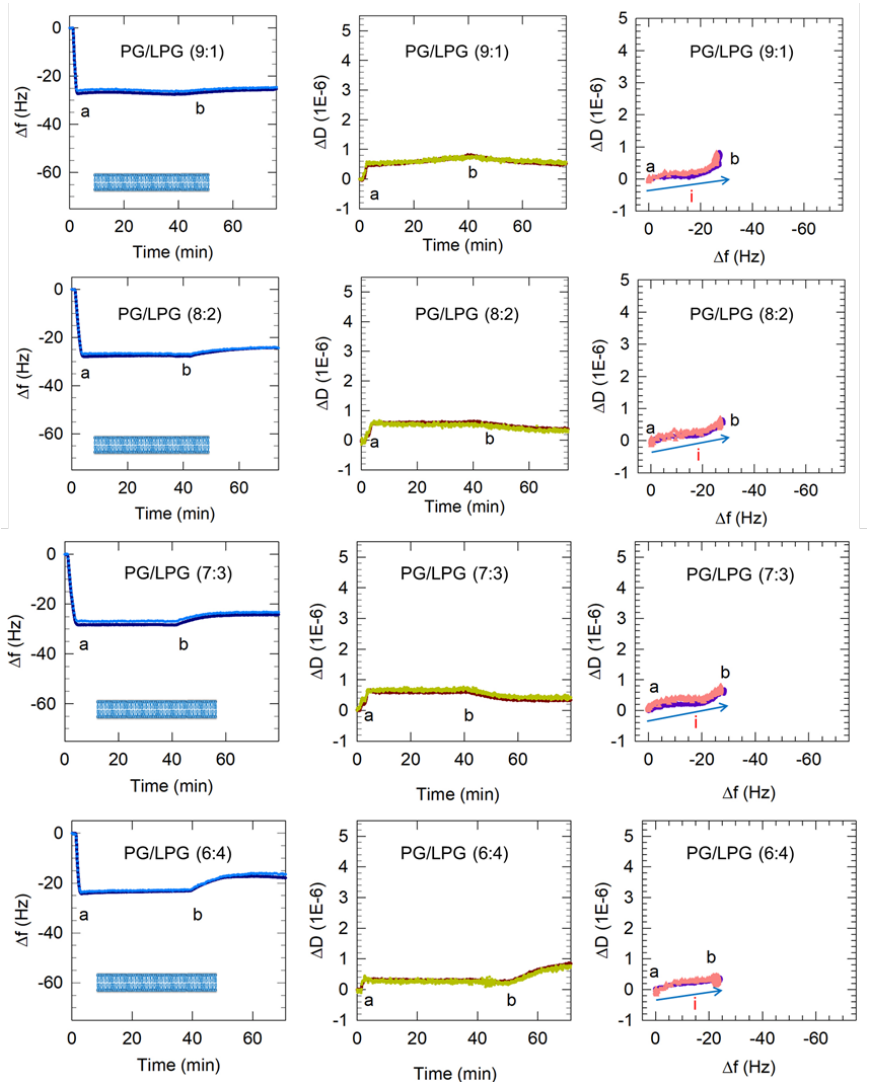
Figure 6. Representative QCM-D results showing the flow of PC vesicles over silica and PG and PG/LPG vesicles over APTMS-coated silica. Time points marking the start and end of vesicle flow, denoted as a and b, are shown in all the plots. Only the 3rd and 11th harmonics are shown for clarity. Based on these QCM-D results, the final membrane configurations for each lipid composition at point b are represented by the graphics in the Δf vs . time plots. In the ΔD vs. Δf plots, the progression of points to the right represents mass increase and the progression to the top indicates increasing viscoelasticity. The blue arrows (labeled i) show the progression of data points over time and the single type of process occurring on the sensor surface. The final buffer rinse following point b indicates some removal of lipid, with the change being significant for the 6:4 PG/LPG system (see discussion below).